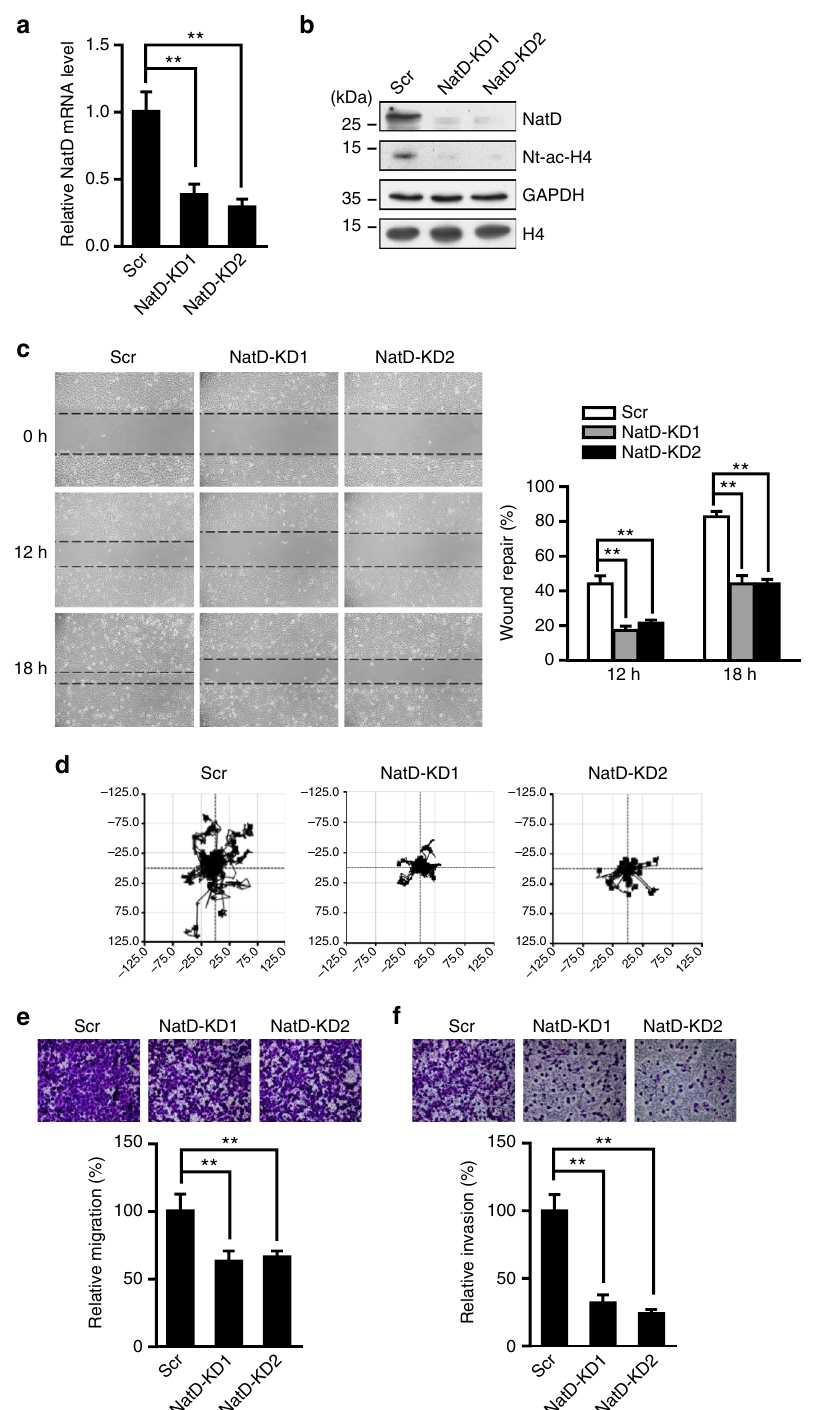
Fig. 2 NatD is required for lung cancer cell migration and invasion in vitro. a Quantitative real-time PCR analysis of NatD mRNA levels normalized to GAPDH in scrambled control cells (Scr) and NatD-KD1 and NatD-KD2 cells. Results are shown as mean ± s.d. from three independent experiments. Two- tailed Student ’ s t -test was used. ** P < 0.01 compared to Scr control. b Western blot analysis of NatD and Nt-ac-H4 protein levels in scrambled, NatD-KD1, and NatD-KD2 cells. GAPDH and histone H4 served as loading controls. Blots are representative of three independent experiments. c Representative images from wound healing assay of scrambled, NatD-KD1, and NatD-KD2 cells from three independent experiments ( left panels ). Wound healing assay results are quanti fi ed in the histogram ( right panel ). Results are shown as mean ± s.d. from three independent experiments. Two-tailed Student ’ s t -test was used. ** P < 0.01 compared to Scr control. d Representative images of the migration of scrambled, NatD-KD1, and NatD-KD2 cells in a time-lapse cell tracker migration assay from three independent experiments. Representative images of the migration ( e ) and invasion ( f ) of scramble, NatD-KD1, and NatD-KD2 cells with transwell assay from three independent experiments ( top panel ). Cell counts for the corresponding assays of at least four random microscope fi elds (×100 magni fi cation). Cell migration and invasion are expressed as a percentage of control ( bottom panel ). Results are shown as mean ± s.d. from three independent experiments. Two-tailed Student ’ s t -test was used. ** P < 0.01 compared to Scr